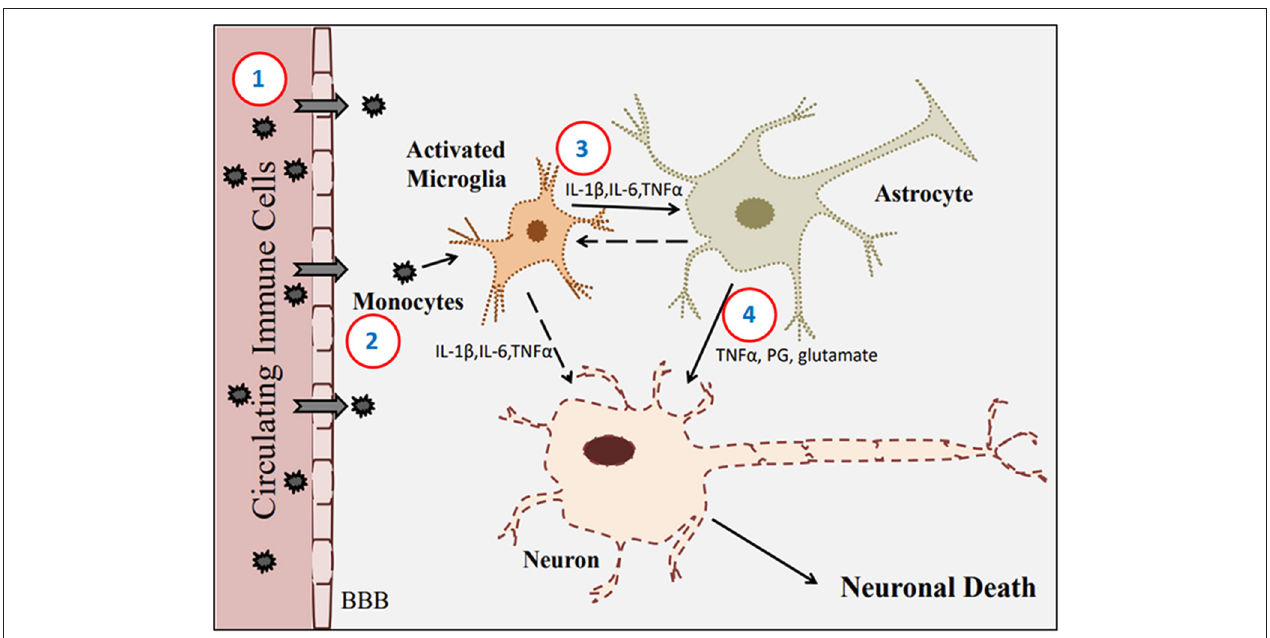
FIGURE 2 | Reactive cellular components-mediated neuroinflammation. 1. SARS-CoV-2 infection induces the immune system, further enhancing circulating immune/inflammatory cell infiltration through the BBB. 2. Monocytes and associated pro-inflammatory mediators activate innate immune cells within the CNS, such as microglia and astrocytes. 3. Activated microglial cells induce release cytokines, which further activate astrocytes. 4. Activated astrocytes release mediators, such as TNF, prostaglandins, and glutamate, mediating neuroinflammation-induced